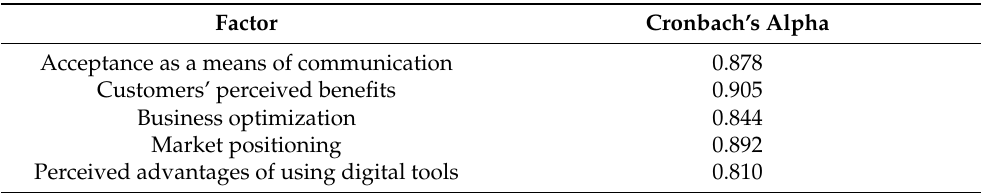
Table 5. Reliability